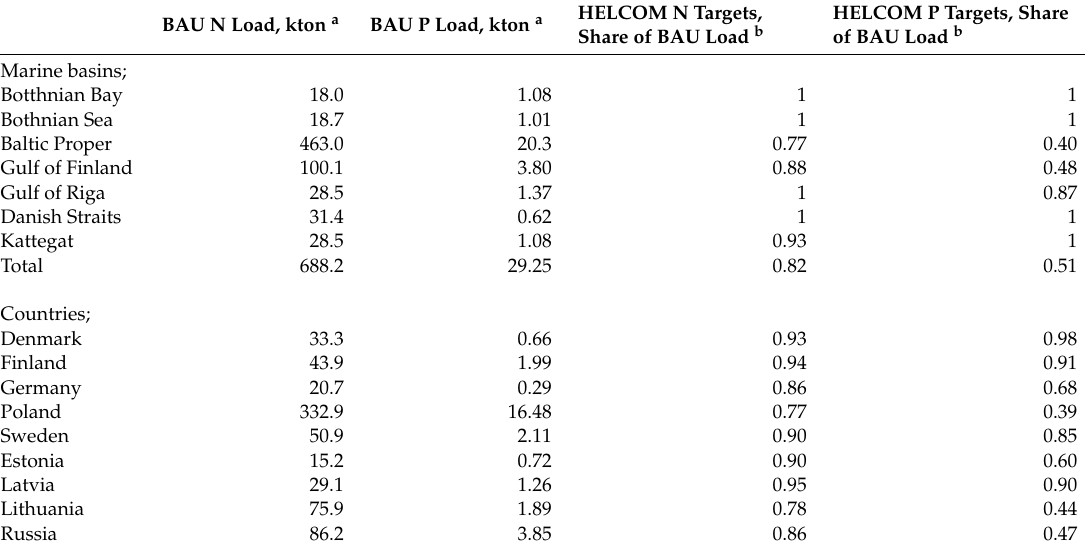
Table 1. Calculated business-as-usual (BAU) nitrogen (N) and phosphorus (P) loads from countries and to marine basins, and maximum load targets as share of BAU